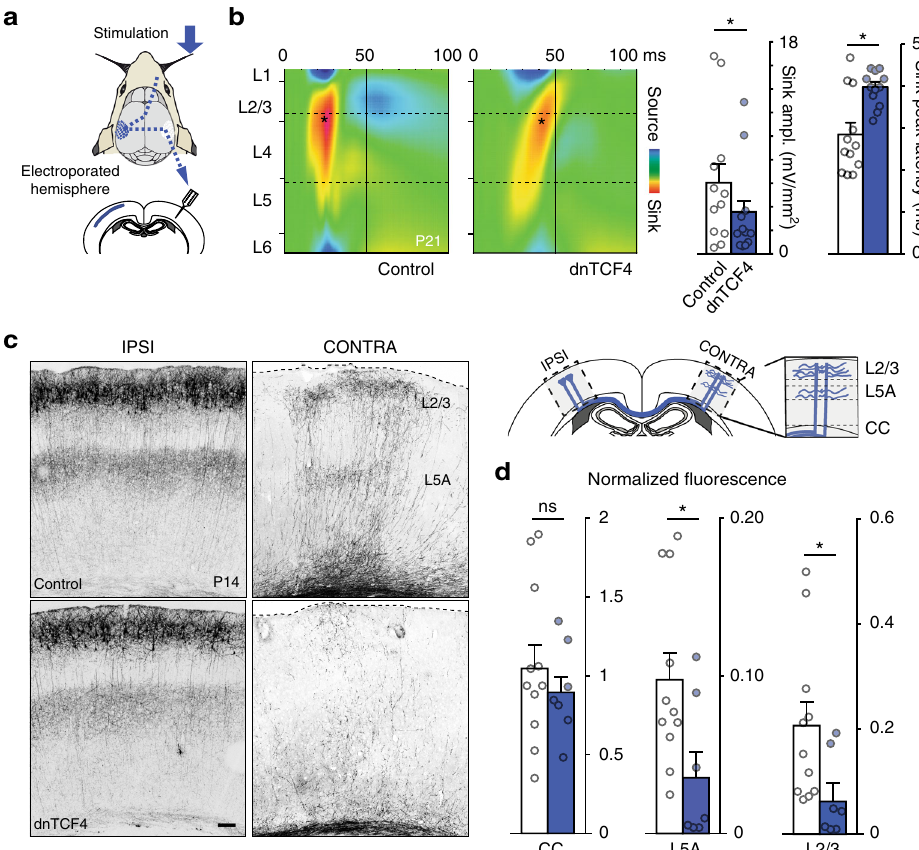
Fig. 4 Delayed migration of CPNs is associated with abnormal interhemispheric connectivity. a Schematic of intracortical recording of whisker-stimulation evoked potentials. b Averaged current source density map of the somatosensory barrel fi eld when recording ipsilateral to whisker stimulation. Graphs illustrate the quanti fi cations of sink peak amplitude and peak latency; n = 12 animals, Wilcoxon test. c Schematic of CPN axons crossing in corpus callosum (CC) and arborizing in contralateral homotypic L2/3 and L5A. Late-arrived CPNs show preserved axonal morphology, with reduction of contralateral arbors at somatosensory cortices. d Average regional fl uorescences normalized by ipsilateral L5A intensity; n = 11 and 7 brains (Control and dnTCF4, respectively), Mann – Whitney, P = 0.4789 for